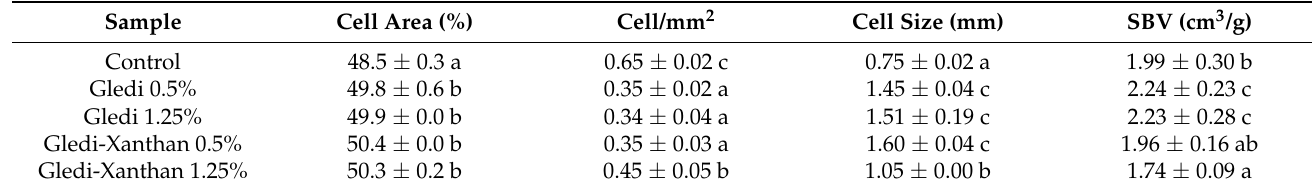
Table 4. Gluten-free bread’s specific volume and crumb structure.